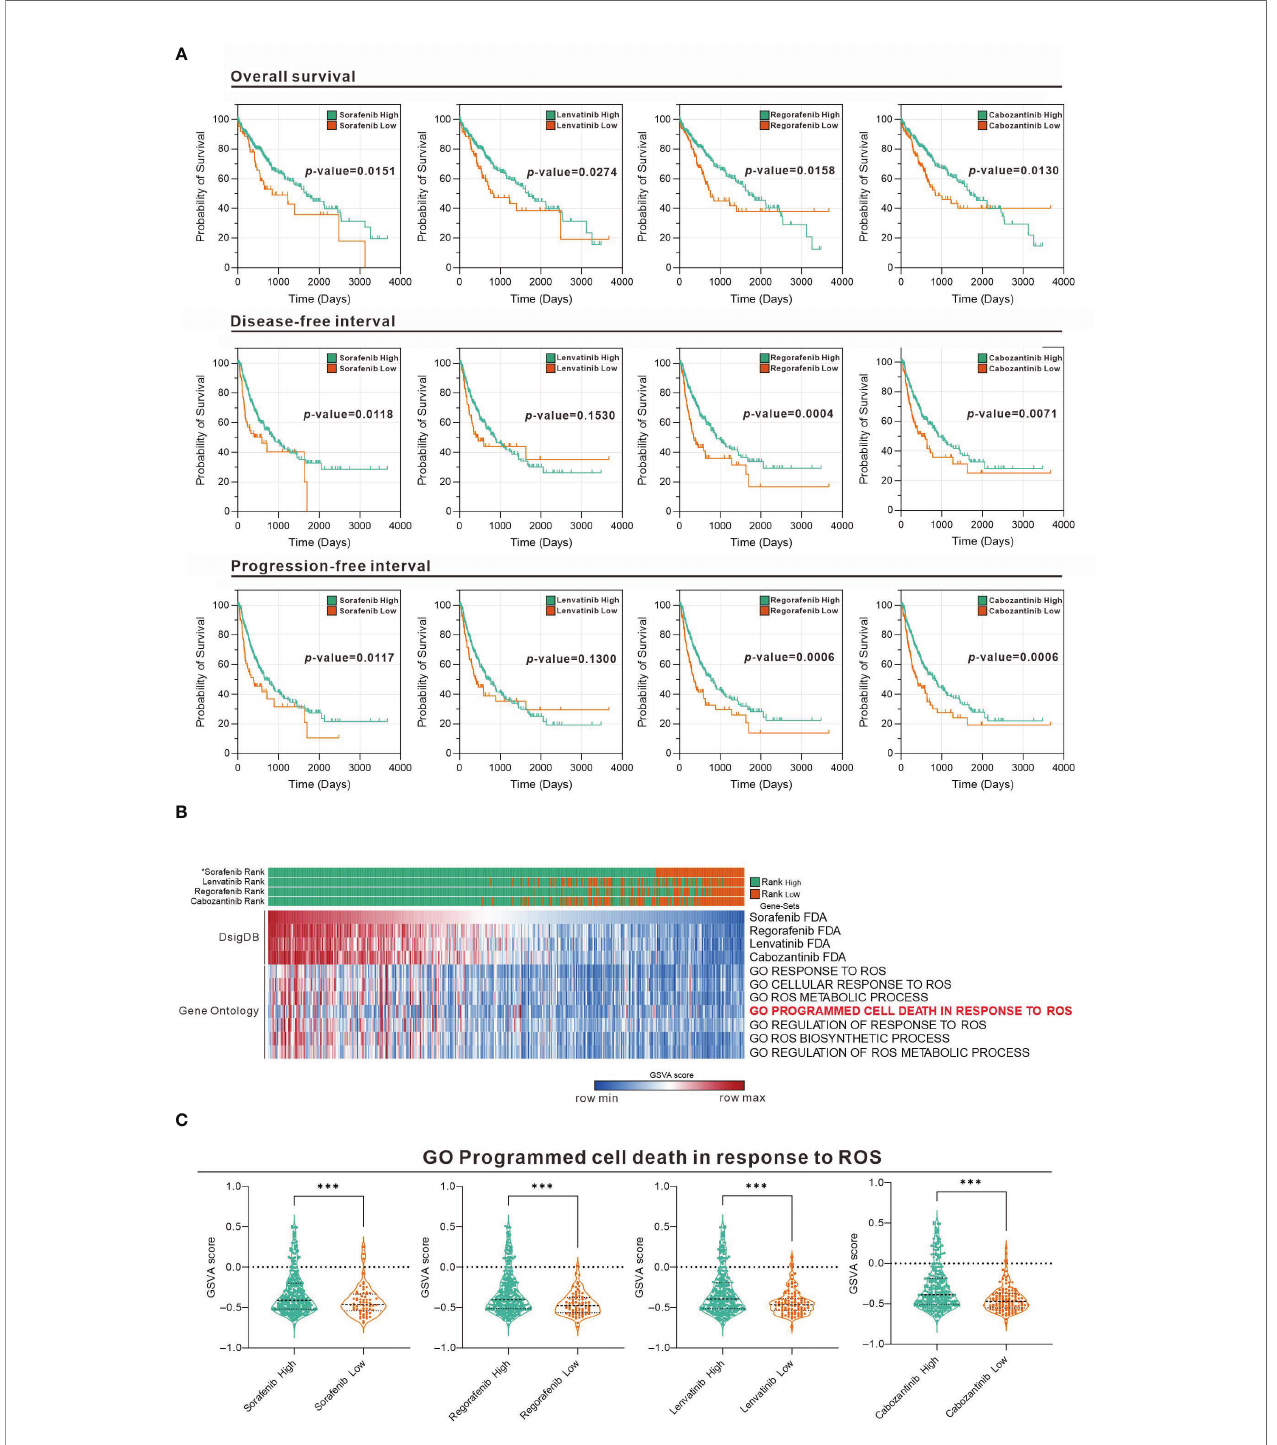
FIGURE 1 | Association between TKI and ROS-responsive gene sets assessed in the TCGA LIHC database. (A) Overall survival, disease-free interval, and progression-free interval analysis for high and low GSVA scoring for the four drugs (sorafenib, lenvatinib, regorafenib, and cabozantinib). (B) Heatmap showing the distribution of the four-drug GSVA high and low and ROS-associated gene sets in TCGA LIHC patients. *: sorted by sorafenib GSVA scores from highest to lowest (sorafenib, lenvatinib, regorafenib, and cabozantinib). (C) Violin plot showing the difference in GSVA scores of GO programmed cell death in response to ROS in the high and low GSVA subgroups of the four drugs. *** p < 0.001 (Welch's